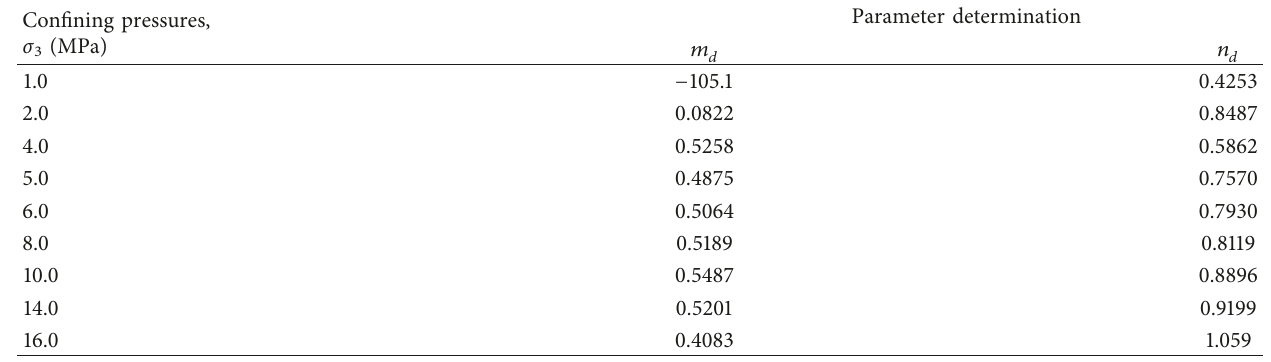
Table 4: Parameter determination of